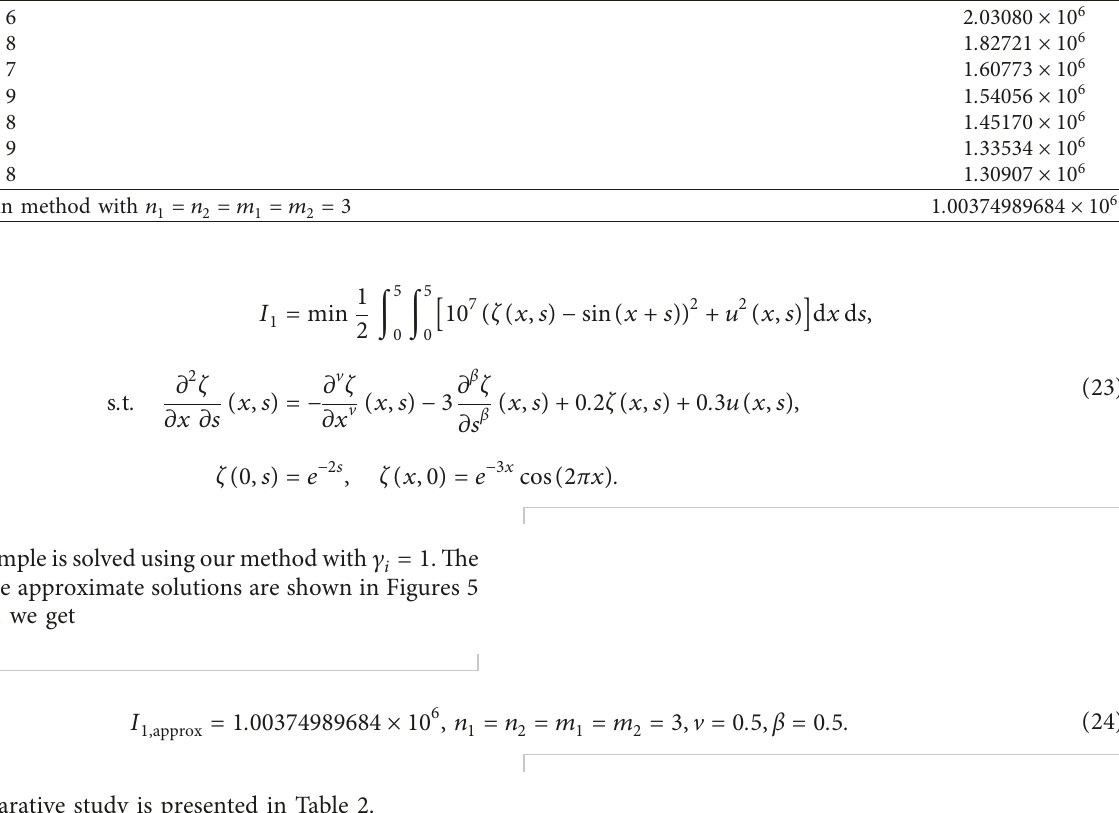
Figure 6: The approximate solution of u